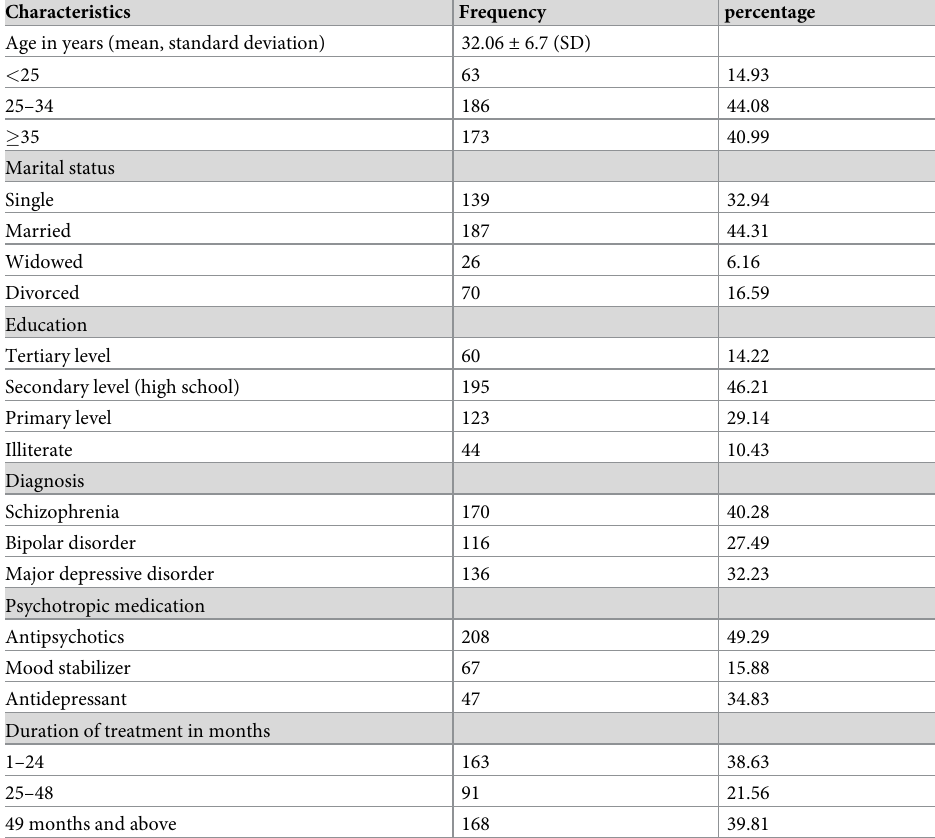
Table 1. Demographic and clinical characteristics of participants (n =